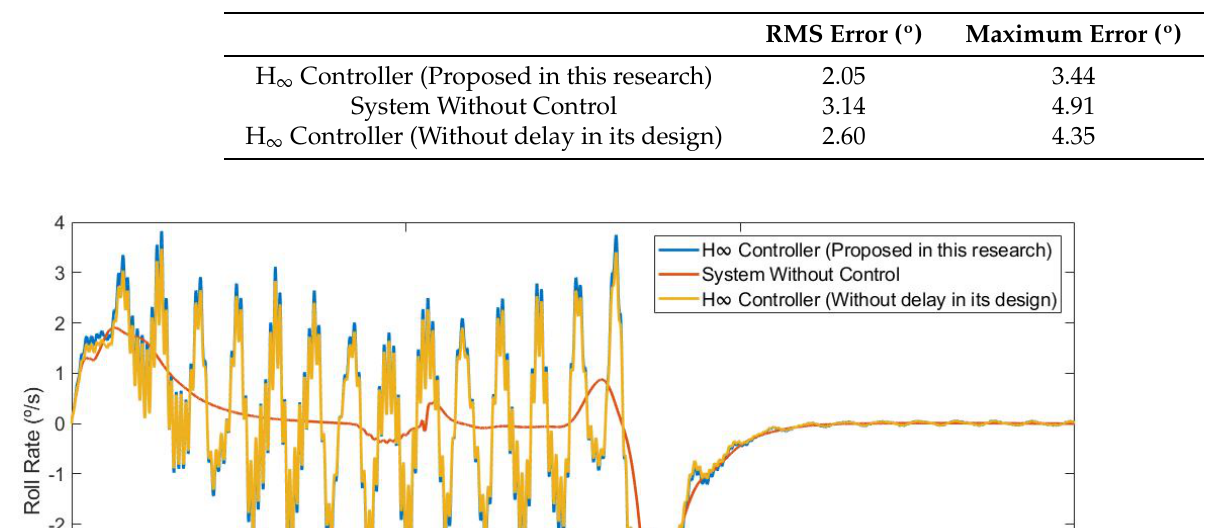
Table 2. RMS and maximum errors of roll angle for test 1.